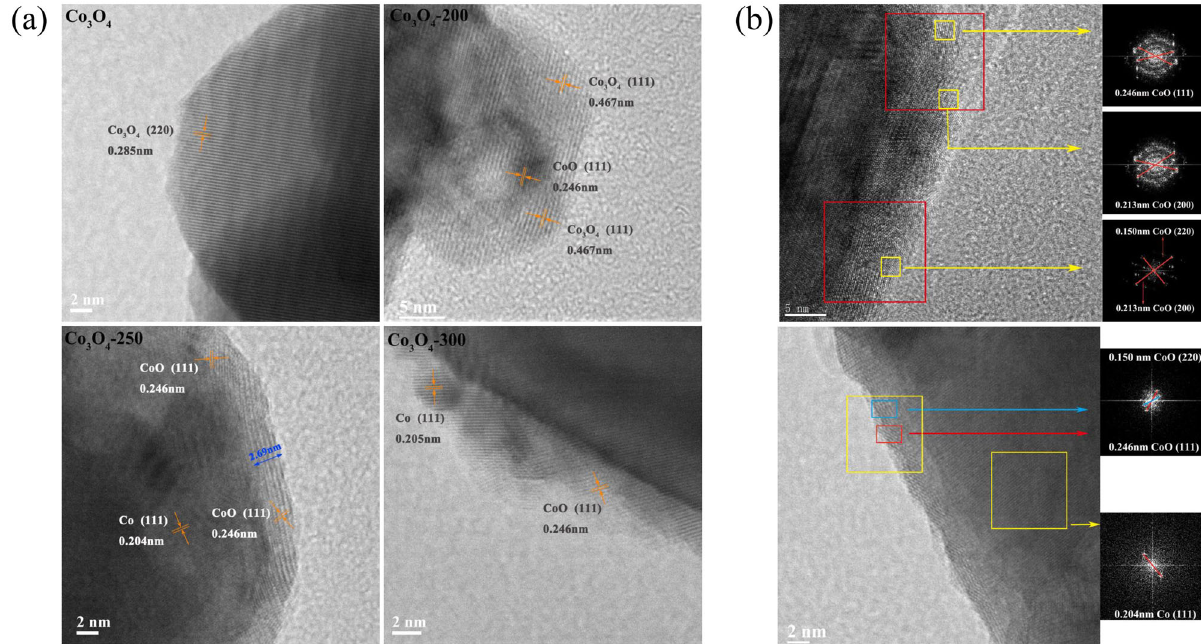
Fig. 3 HRTEM images of various catalysts. a HRTEM images of selected catalysts (unreduced Co 3 O 4 , Co 3 O 4 -200, Co 3 O 4 -250 and Co 3 O 4 -300); b representative HRTEM images of Co 3 O 4 -250. The HRTEM images of Co 3 O 4 -250 clearly show the closed shell of CoO, with the thickness of 2 – 3 nm and CoO(111), CoO(200)